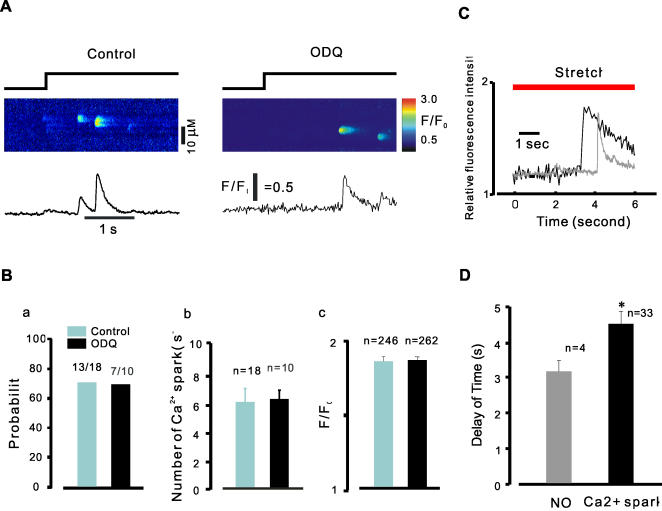
Ca2+ spark property was not altered by ODQ.A, sample of linescan images obtained from stretched smooth myocytes. Compared to control (A, left), there was no significant change of the Ca2+ spark probability (A, right), frequency, and peak Ca2+ in the presence of ODQ. B, summary data of probability (a, n = number of experiments), frequency (b, n = number of experiments), and peak Ca2+ (c, n = number of sparks) of Ca2+ sparks. C & D, profiles and summary data show the relationship of NO and stretch-induced Ca2+ spark, indicating NO always occurred prior to Ca2+ sparks (n = number of experiments, *P<0.05).